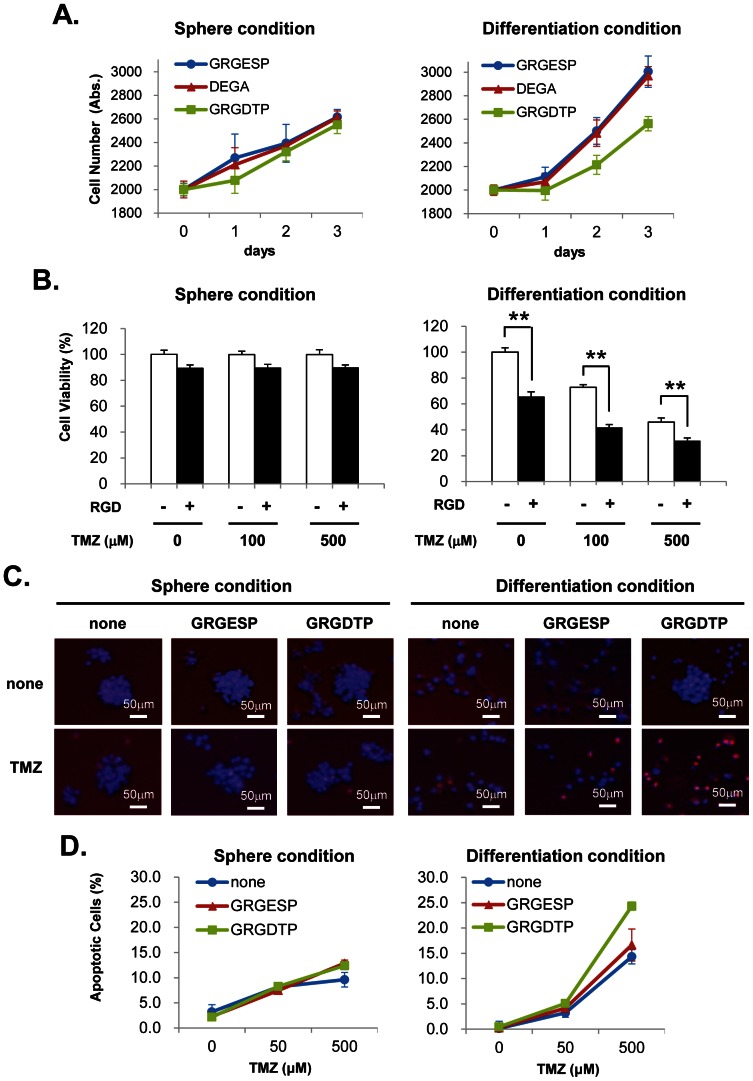
Treatment of RGD peptide and TMZ decreases cellular viability of GICs during serum-induced differentiation.
A. GIC spheres or serum induced differentiating GICs were treated with GRGESP as control (blue), and RGDTP (green) or DGEA peptide (red) as integrin-binding peptide for 3 days, and their cellular viabilities were analyzed with WST-8 assay. B. GIC spheres or serum induced differentiating GICs were treated with TMZ (0, 100, 500 µM) and/or RGD peptide for 3 days, and analyzed by WST-8 assay. The values shown in (A) and (B) are means ±S.E of three independent experiments. **p<0.01. C. Representative morphological changes of GIC spheres or differentiating cells after 4 days of the treatments with RGD peptide (300 µM) or TMZ (500 µM) alone, or both of agents. The cells were stained with PI for counting the apoptotic cells (red), and Hoechst 33342 for staining the total cells (blue) D. Effects of the RGD peptide and TMZ on GIC spheres and differentiating cells. GIC spheres or serum induced differentiating cells were treated with an integrin-binding peptide (GRGDTP: green), a control peptide (GRGESP: red), or control buffer (blue), and followed by the treatment of TMZ (0, 100, 500 µM) for 4 days, The percentage of apoptotic cells were calculated from the cell number of PI staining cells (for apoptotic cells) in the Hoechst staining cells (for total cells) by MetaMorph software. Data are shown as the mean of 12-field counts in two experiments ±S.E as described in Material and Methods.